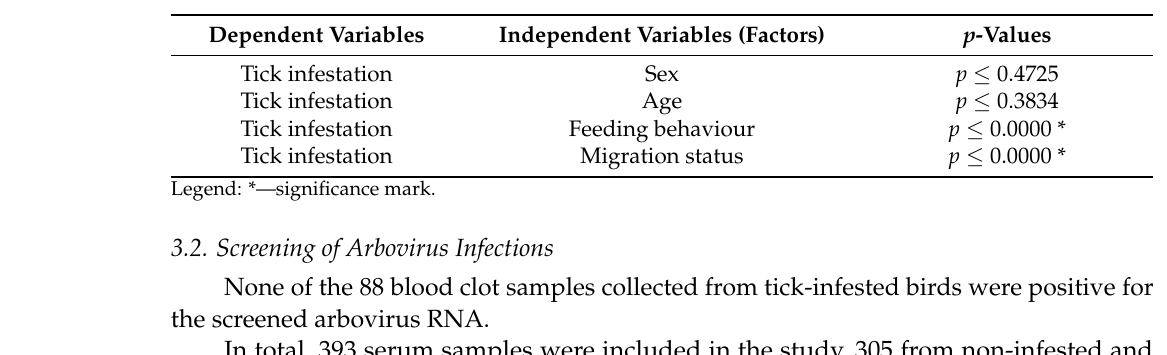
Table 3. Results of Fisher’s exact tests for determining the difference between tick-infested and non-infested birds in selected bird species where at least one bird was infested with ticks in sex, age, feeding behaviour and migration